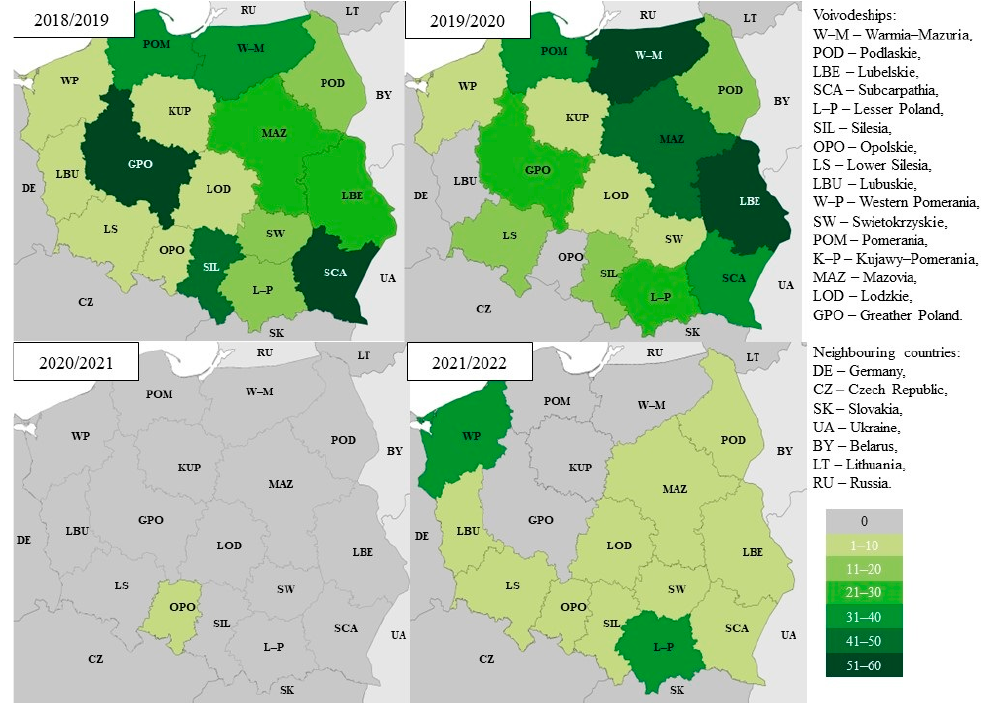
Figure 6. Comparison of positive samples in the last four epidemic seasons divided into voivodships in Poland. in